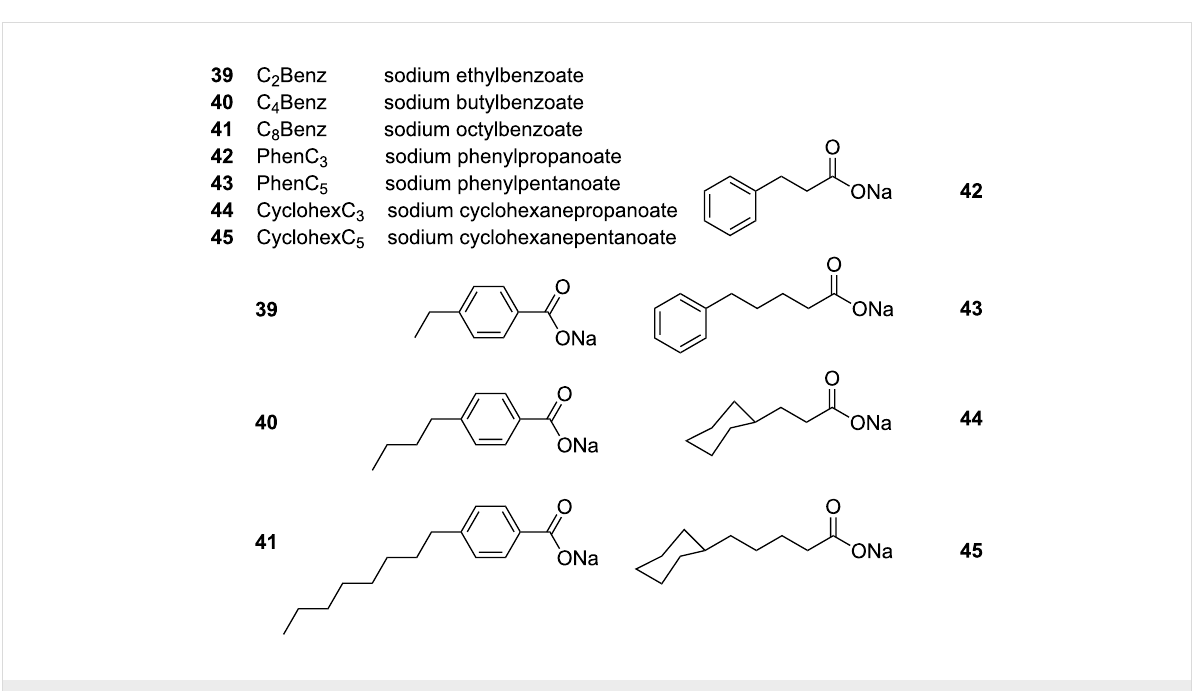
Figure 7: Abbreviated names and structures of hydrotropes tested by Hatzopoulos et al.